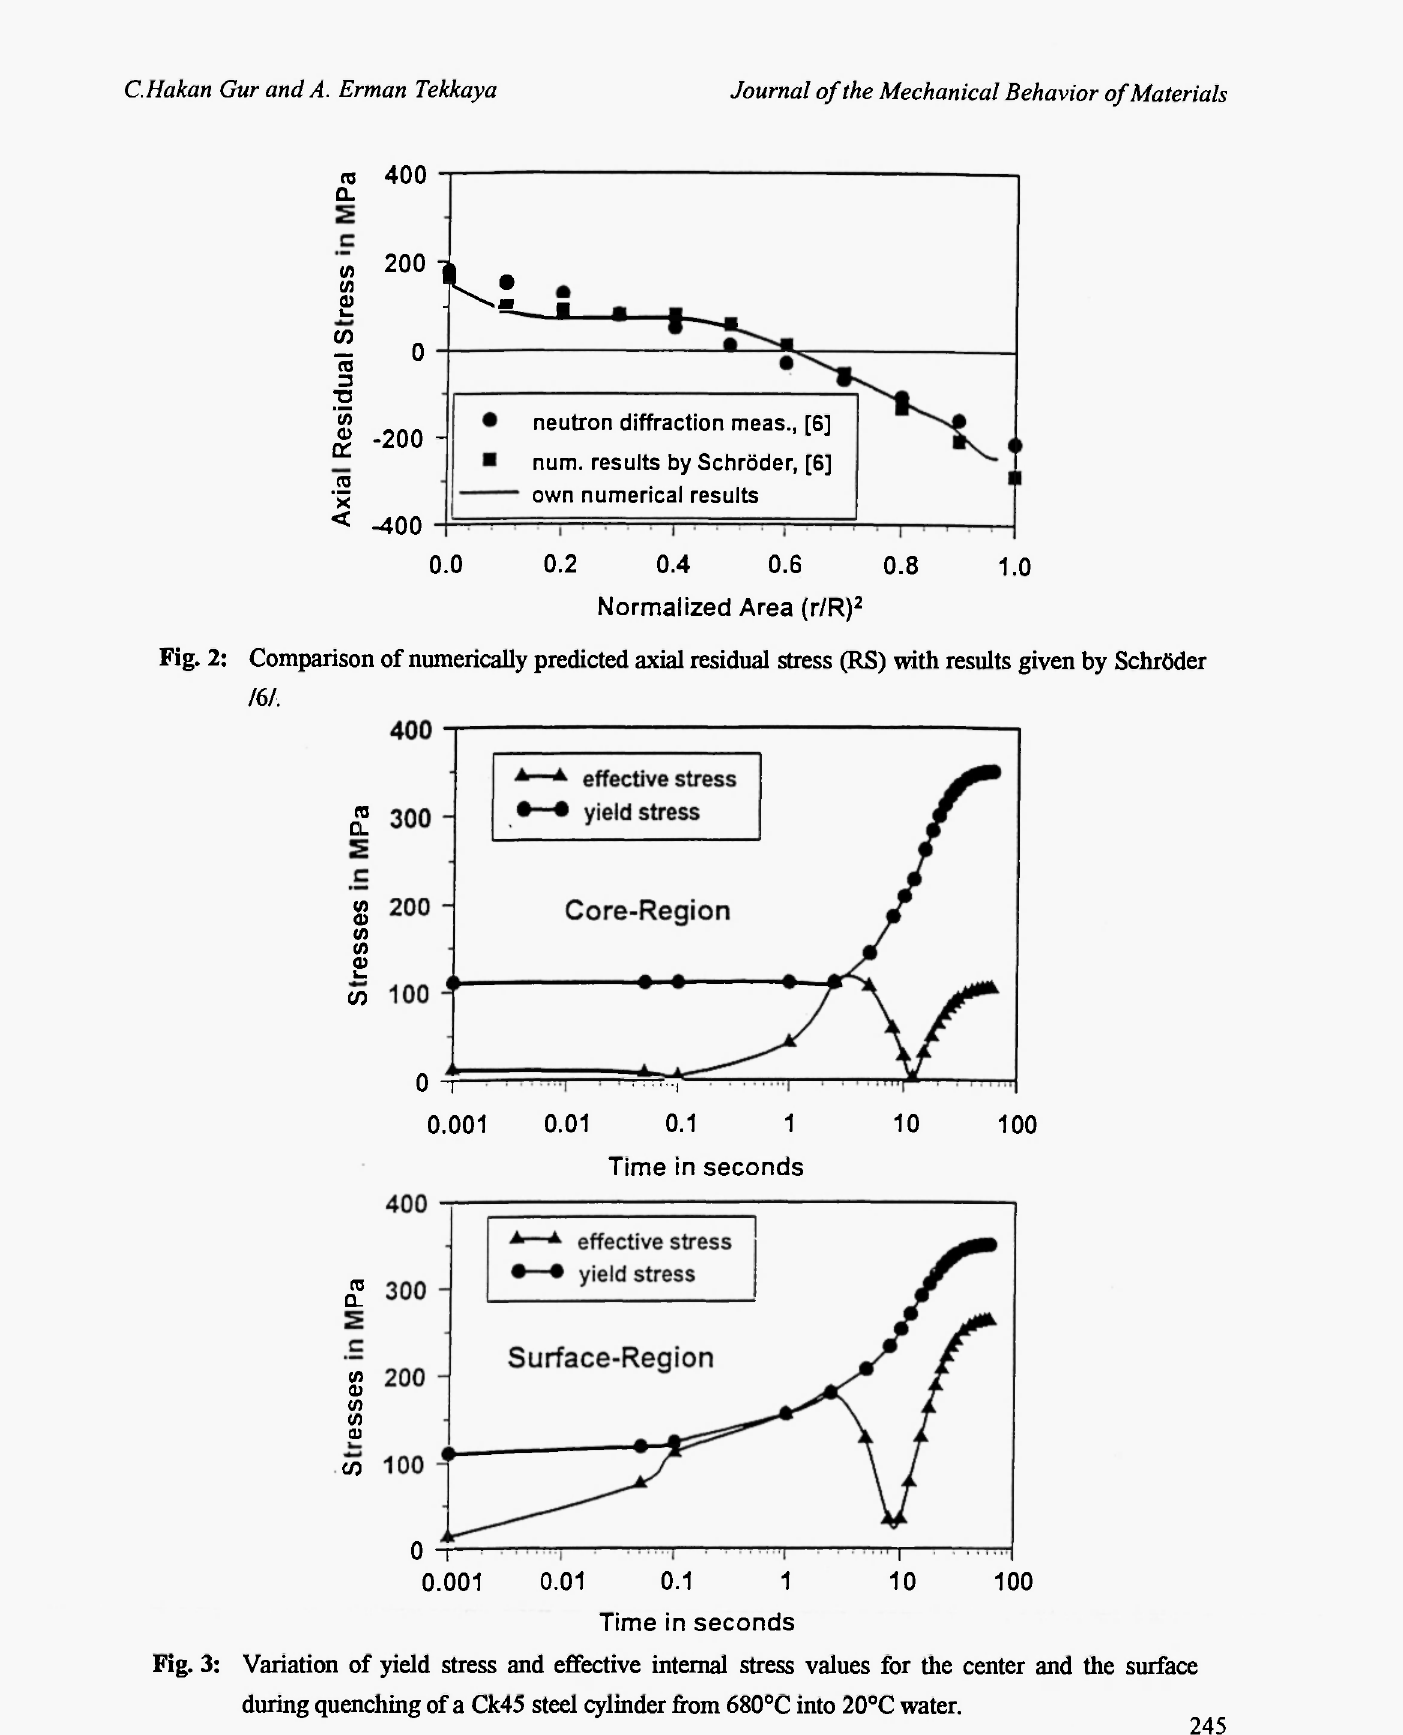
Fig. 3: Variation of yield stress and effective internal stress values for the center and the surface during quenching of a Ck45 steel cylinder from 680°C into 20°C